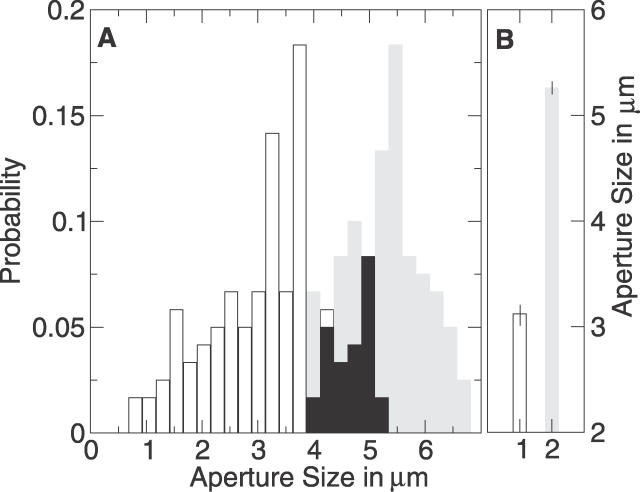
Stomatal Aperture Distributions without ABA Treatment (gray bars) and with 50 μM ABA (white bars)(A) The x axis gives the stomatal aperture size and the y axis indicates the fraction of stomata for which that aperture size was observed. The black columns indicate the overlap between the 0 μM ABA and the 50 μM ABA distributions.(B) Classical bar plot representation of stomatal aperture for treatment with 50 μM ABA (white bar, labeled 1) and without ABA treatment (gray bar, labeled 2) using mean ± standard error. This representation provides minimal information on population structure.